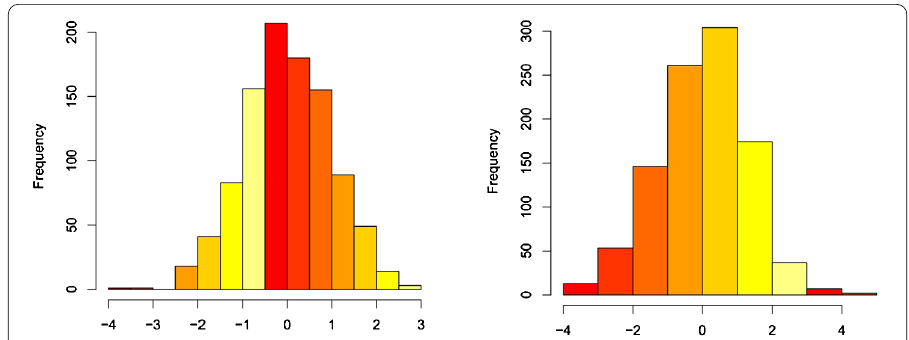
Figure 4 1000 Monte Carlo simulations of Example 5.1 with a = 1, b = 7, σ = 1, r = 1, T = 10, and (cid:7) = 0.01 and x 0 = 10. (Left) The histogram of the first element of β T . (Right) The histogram of the second element of β